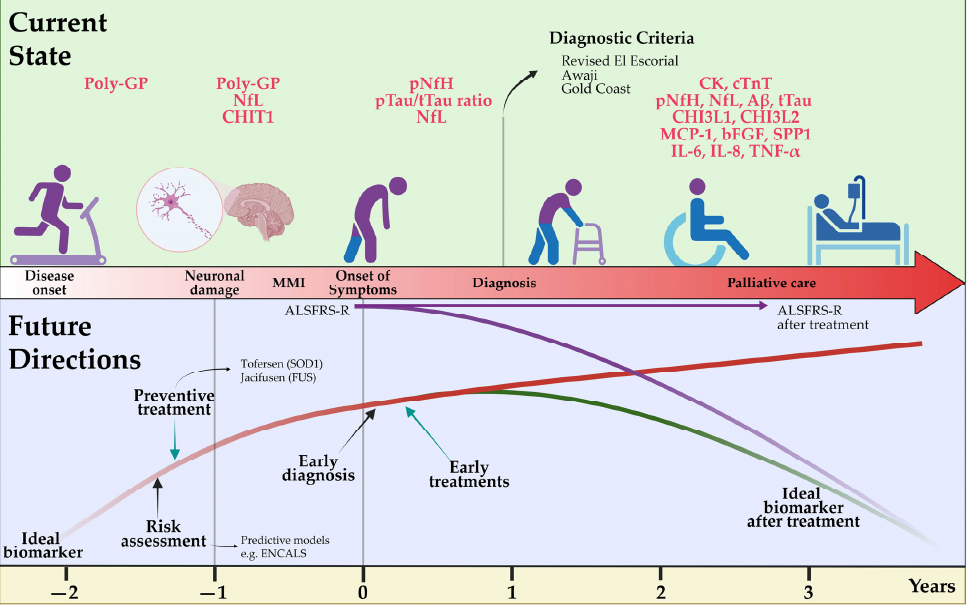
Figure 2. Current state of and future directions for the diagnosis of amyotrophic lateral sclerosis. A delayed diagnosis of ALS is still currently performed using clinical criteria such as Revised El Escorial, but the determination of fluid biomarkers such as Nf is accelerating an earlier identification of the disease. In the future, the availability of more specific biomarkers related to disease pathology onset will allow early risk assessment and definitive diagnosis in patients in prodromal phases. Additionally, an ideal biomarker should develop preventive therapies and monitor disease activity in patients under novel causative therapies. ALSFRS-R: Revised Amyotrophic Lateral Sclerosis Functional Rating Scale; A β : Amyloid β ; bFGF: basic fibroblast growth factor; CHI3L1: chitinase-3-like protein 1;